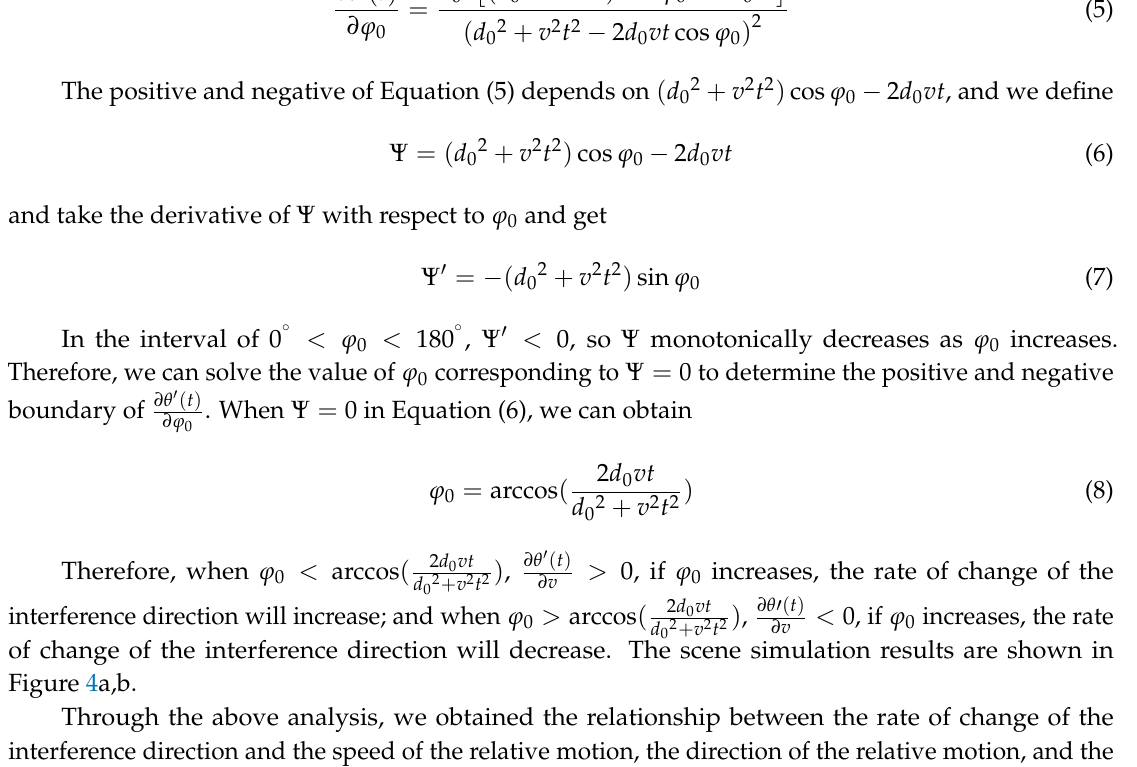
interference direction in the case where d 0 < vt ; ( b ) the change of the interference direction in the case where d 0 > vt .